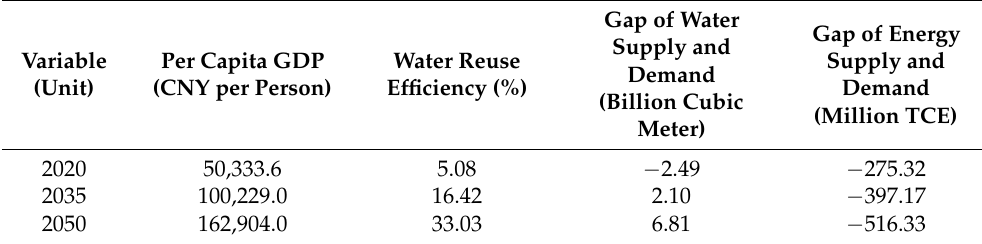
Table 2. Trends of social and economic variables in the Hebei urban metabolic system in 2020, 2035, and 2050.